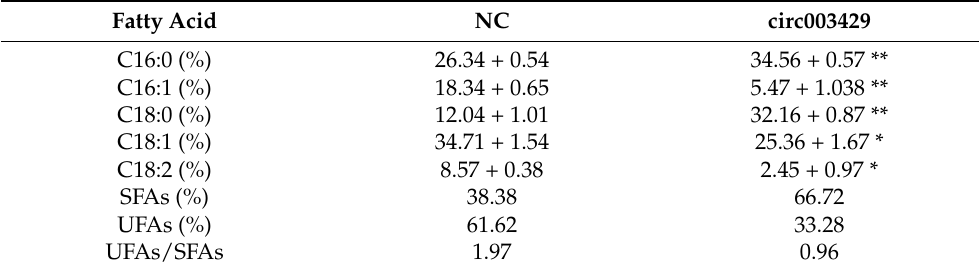
Table 3. Effects of circ003429 on fatty acids composition in GMECs.